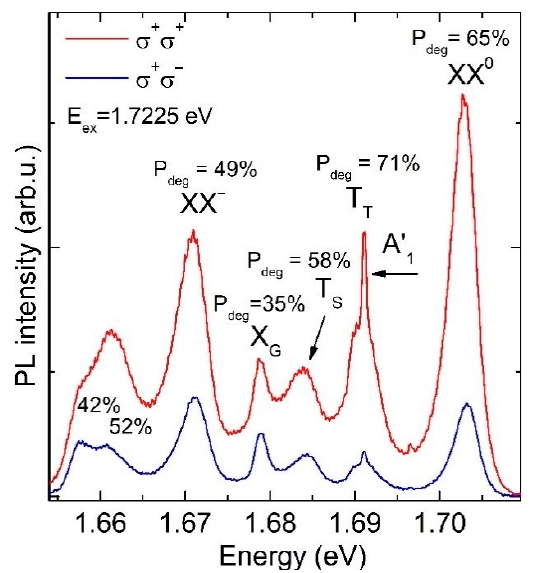
Figure 5. Helicity-resolved PL spectra recorded in two circular polarization configurations of exciting and emitted light: Co-polarized, σ + / σ + (red line), and cross-polarized, σ + / σ − (blue line). The laser light is in resonance with the X A transition at 1.7225 eV. The origin and circular polarization of the emission of all lines are marked. The black arrow marks the position of the A ′ 1 (WSe 2 ) Raman mode.